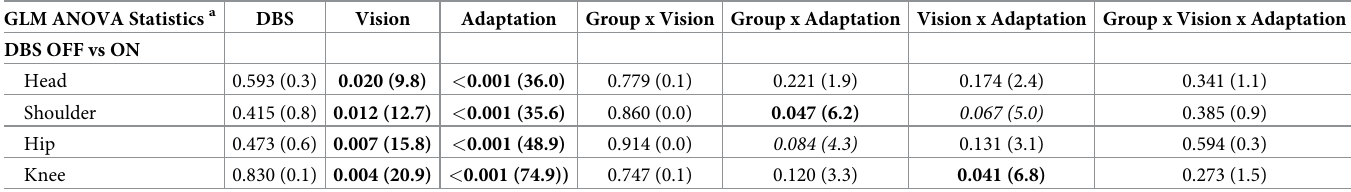
Table 5. DBS, vision and adaptation effects on the size of the body movements. GLM ANOVA Statistics